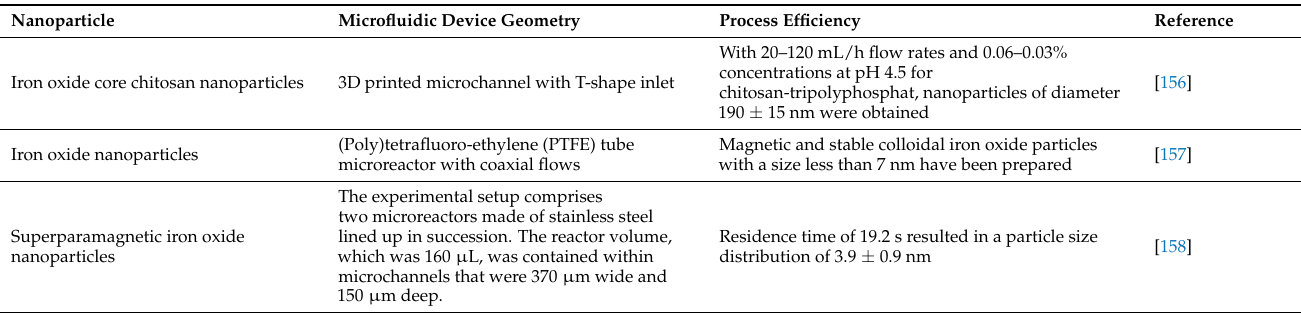
Table 4. Some examples of use of microfluidic systems for nanoparticle